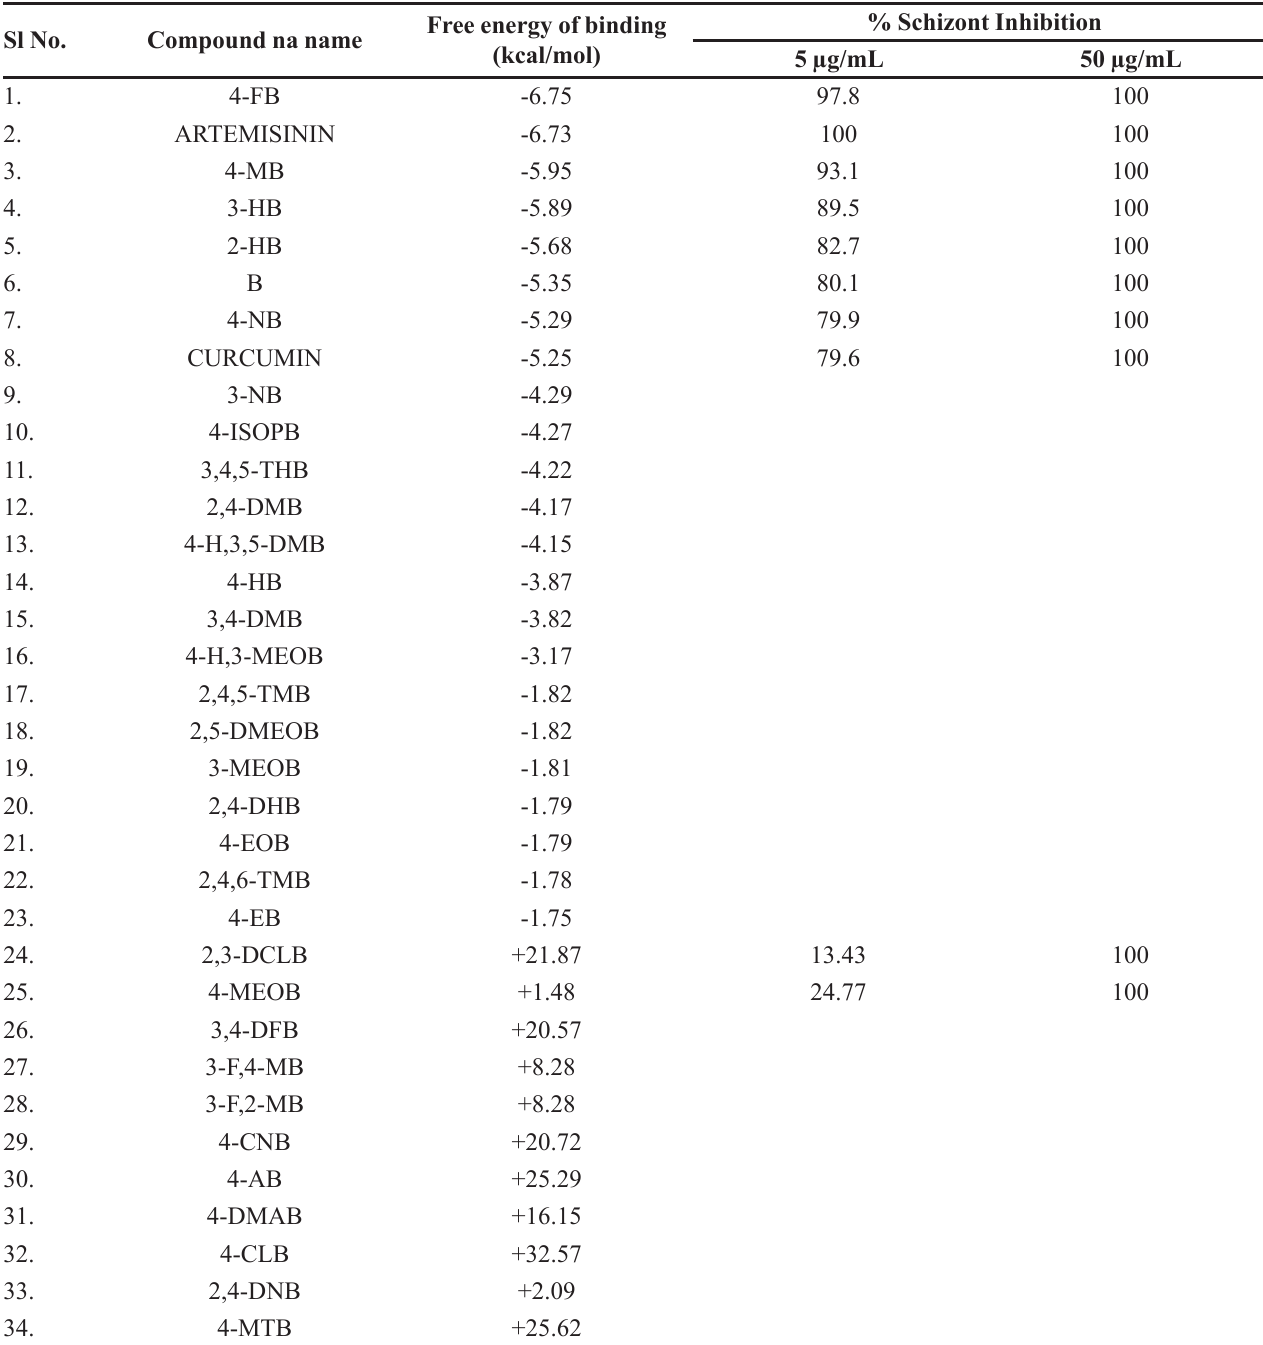
TABLE II - Free energy of binding and in vitro screening results Sl